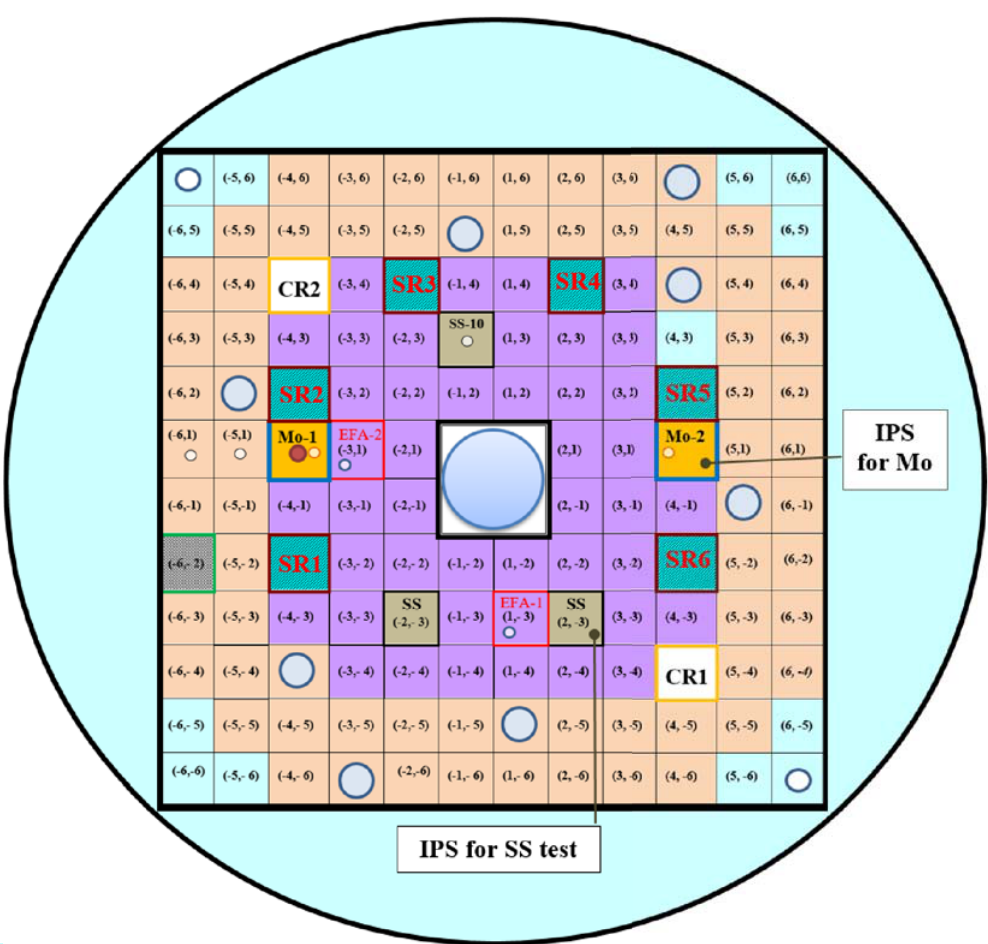
Figure 2. The SC11 sub-critical core